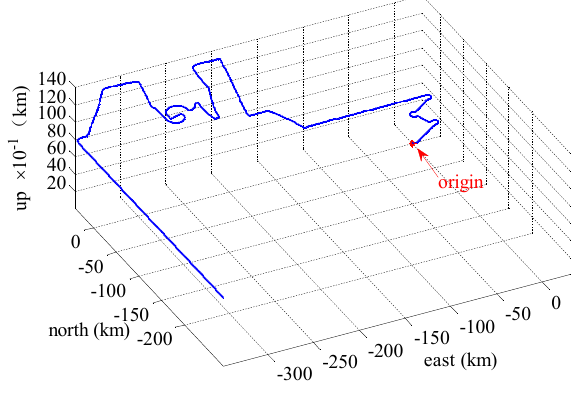
Figure 7. Aircraft trajectory.